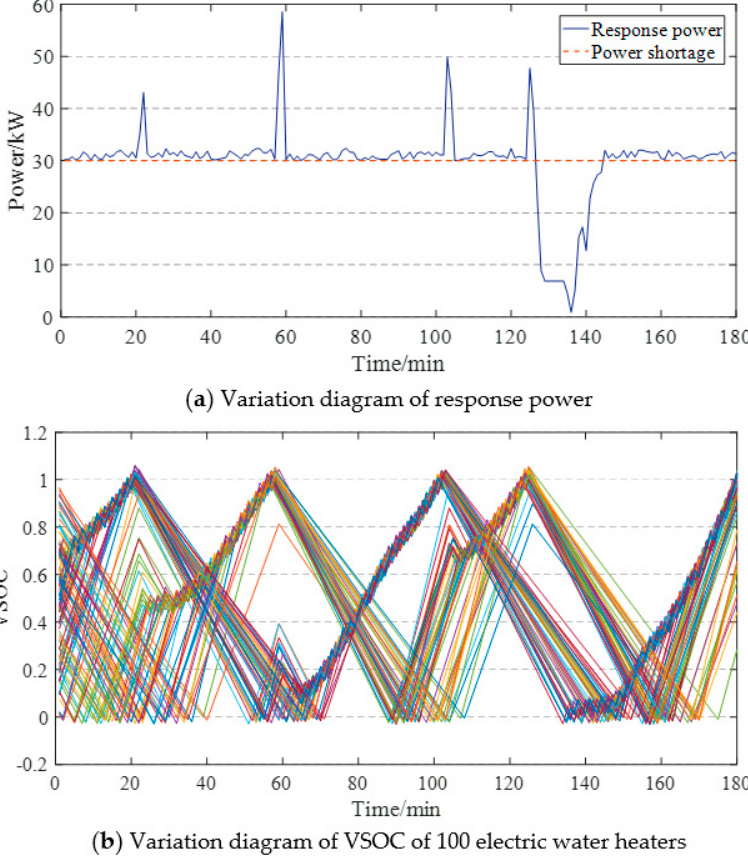
Figure 9. The response variation of power and VSOC in 180 min.